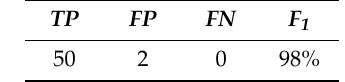
Figure 10. A flowchart depicting the evaluation procedure. The test data flows through a pipeline, similar to the inference pipeline, but without the post ‐ processing steps. The predicted segmentations are then compared with manually created label masks, according to the two mentioned metrics.